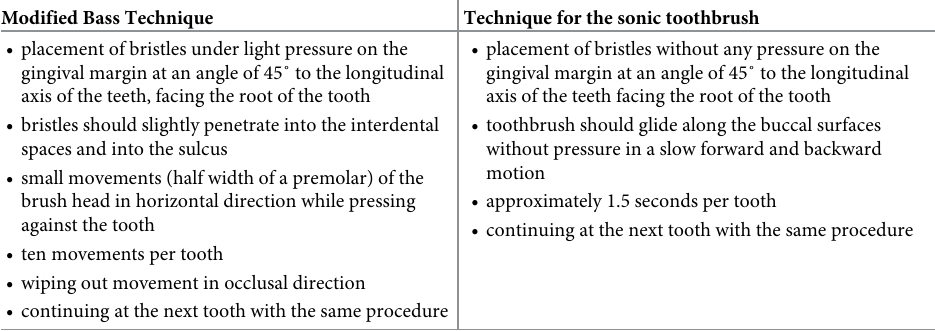
Table 1. Description of instruction of the toothbrushing